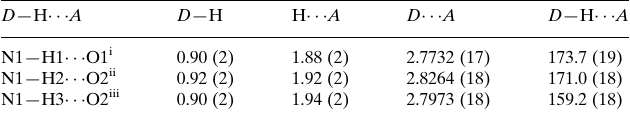
Hydrogen-bond geometry (A˚ , (cid:2) ).